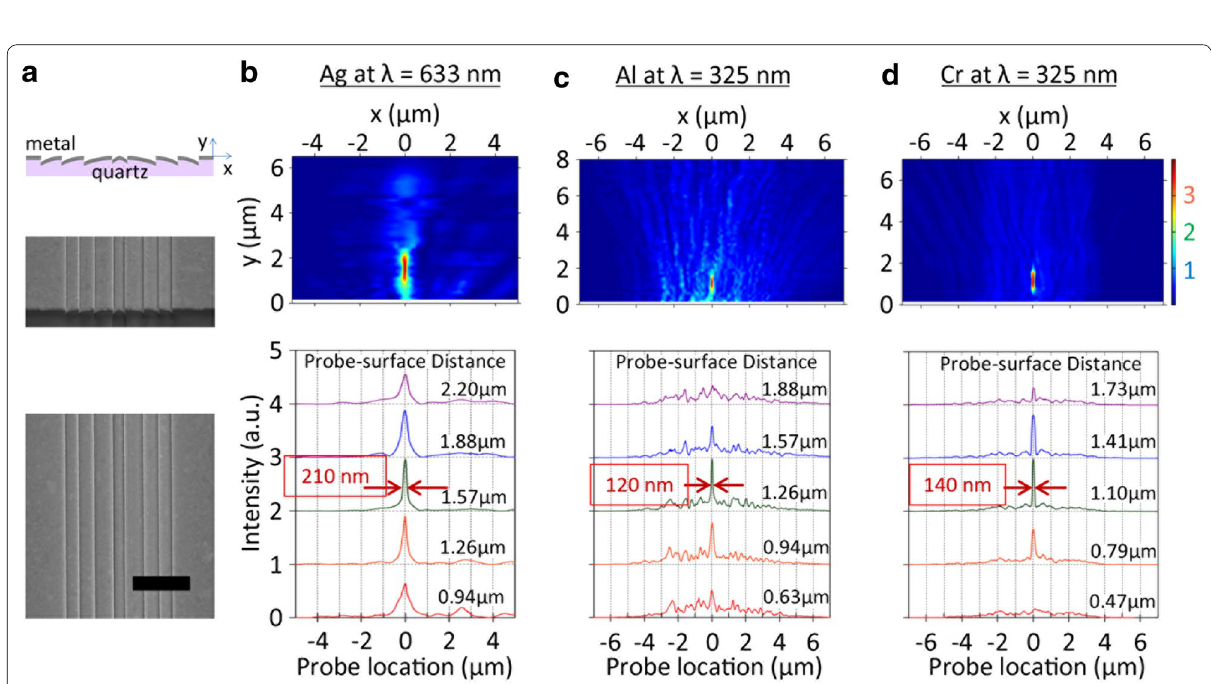
Fig. 5 Subdiffraction-limited focusing of light with a tilted nanoslit array lens. a SEM image of an 8-slit Ag lens. Scale bar, 3 µm. b Ag lens characterized at 633 nm wavelength. NSOM scan image (top) and scan profiles (bottom). A minimal spot size is measured to be 210 nm FWHM at y 1.57 µm. c Al lens at 325 nm wavelength. A minimal spot size of 120 nm is observed at y = spot size of 140 nm is observed at y 1.10 =